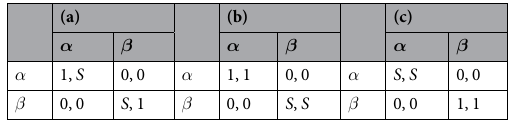
Table 2. Possible payoff situations in BoS on a network, where 0 < S <